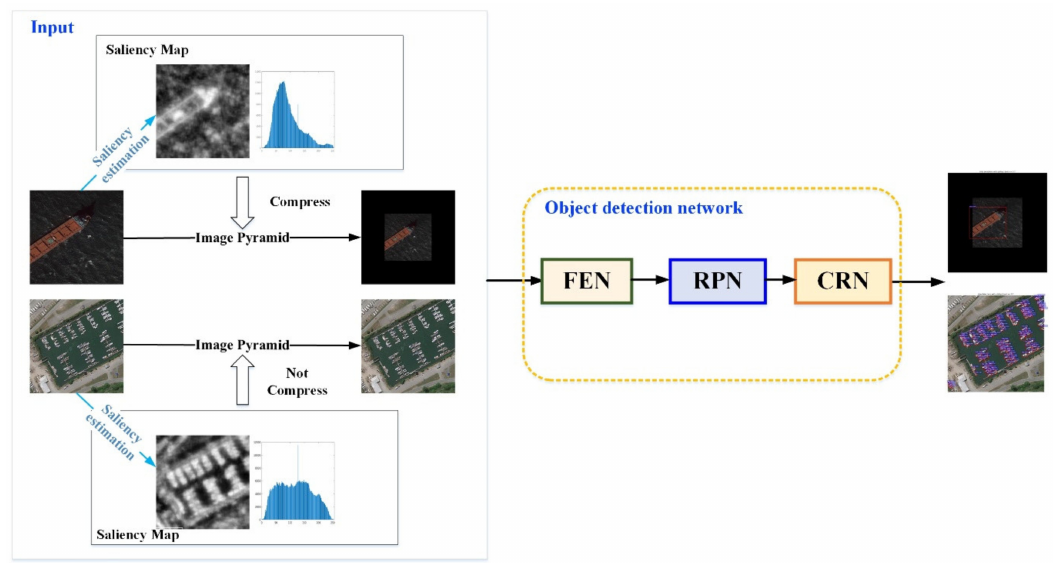
Figure 8. The framework of the Saliency-Faster R-CNN for the multi-scale object